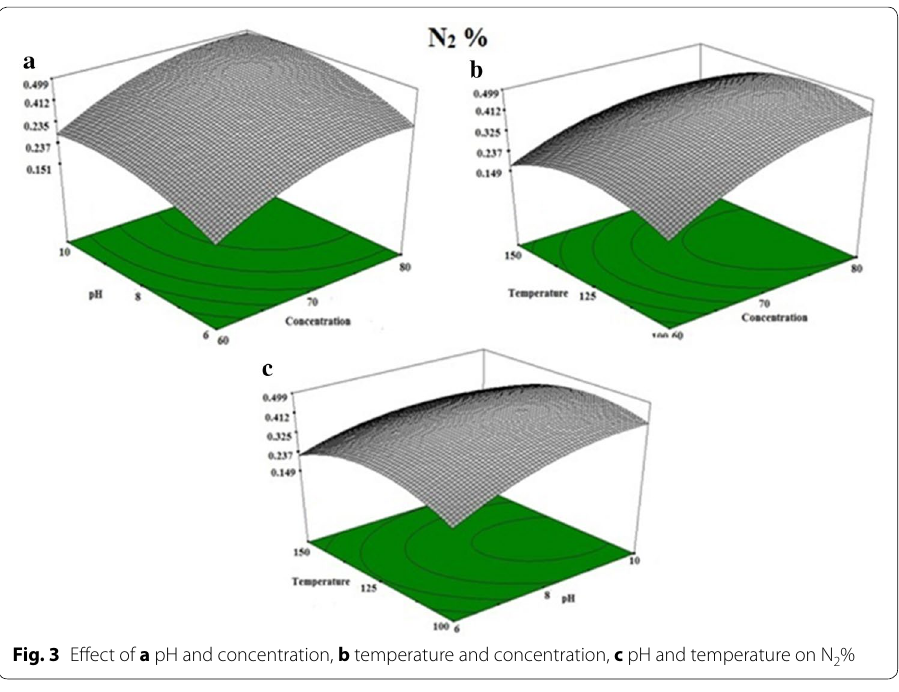
Fig. 3 Effect of a pH and concentration, b temperature and concentration, c pH and temperature on N 2 %